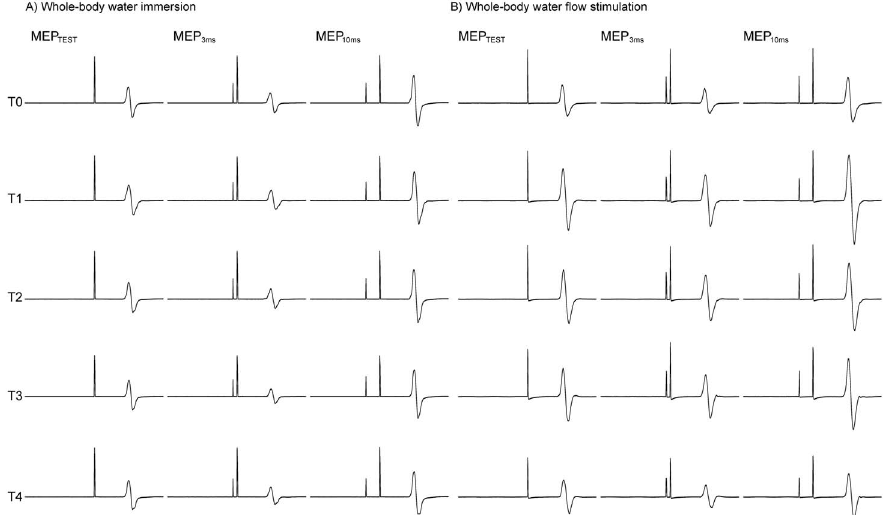
Figure 4. Raw data traces from a representative subject for each intervention. Averaged MEPs for the test stimulus (TS) alone, after conditioning stimulus (CS) by TMS at ISIs of 3 and 10 ms in (A) whole-body WI and (B) whole-body WF.